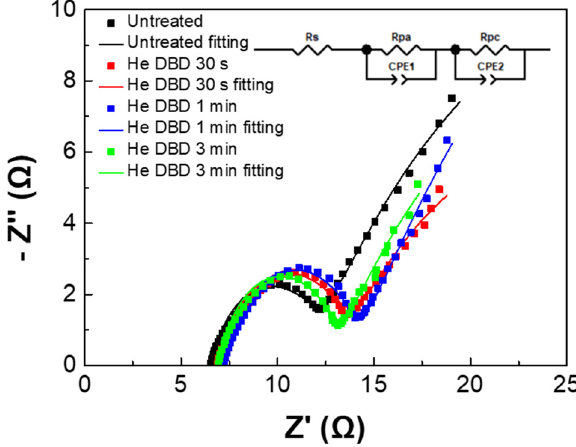
Figure 9. The Nyquist plot of EIS.